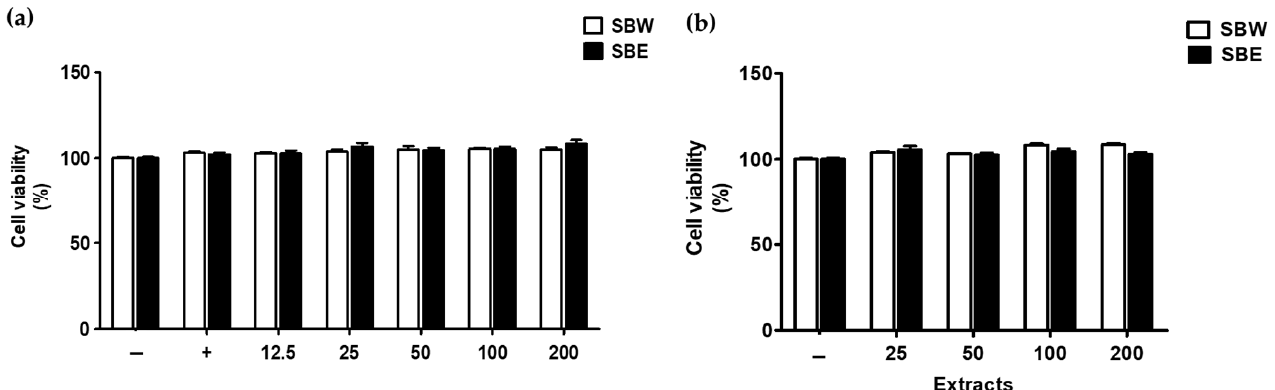
Figure 1. ( a ) SB extracts (12.5 to 200 µg/mL) and H 2 O 2 (50 µM) did not show toxicity in PC12 cells. ( b ) SB extracts (25 to 200 µg/mL) did not show toxicity in PC12 cells. SBW, Sasa borealis water